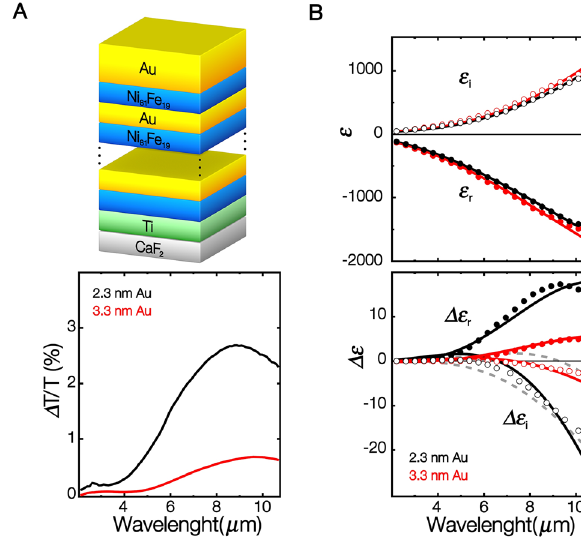
Figure 7: Schematic, MRE spectra,dielectric constantand magnetic modulation of dielectric constant in Ni 81 Fe 19 /Au multilayers with differentvaluesofGMR.(A)Upperpanel.-SchemaoftheNi 81 Fe 19 /Au multilayer internal structure. Lower panel. - MRE spectra ( Δ T/T=(T P -T AP )/T AP ) of unpolarized light at normal incidence for two multilayers with different Au thicknesses. (B) Upper panel. - Spectra of the real (full dots) and imaginary (empty dots) parts of the effective dielectric constant of the two multilayers: dots are experimentalvaluesandlinestheoretical fi ts.Lowerpanel.-Spectra of the difference of the dielectric constants, Δε = ε P - ε AP (full dots: real part; empty dots: imaginary part) for the two multilayers. The dots correspond to experimental values, the red lines represent a theoretical fi t for a multilayer with 0.8% GMR, and the gray dashed lines and black lines represent two theoretical simulations for a multilayer with 4% GMR, (see text). Adapted with permission from ref [61], © The Optical